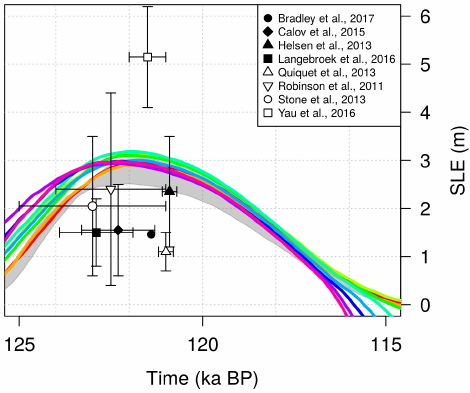
Figure 11. GrIS ice volume evolution simulated for different val- ues of the melting rate sensitivity κ during the last deglaciation. The ice volumes have been converted to values of s.l.e. anomaly with respect to the present-day volumes estimated in each specific sim- ulation. As in Fig. 10, grey shading represents the simulations for the different reference basal melting rates ( B ref ) investigated for the case of constant-in-time oceanic forcing ( κ = 0). The upper bound refers to B ref = 40ma − 1 and the lower bound to B ref = 0ma − 1 . Grey dots and orange shading indicate estimates of the GrIS ice volume at the LGM (21kaBP) and at the maximum ice volume reached before the last deglaciation (16.5kaBP), as suggested by previous